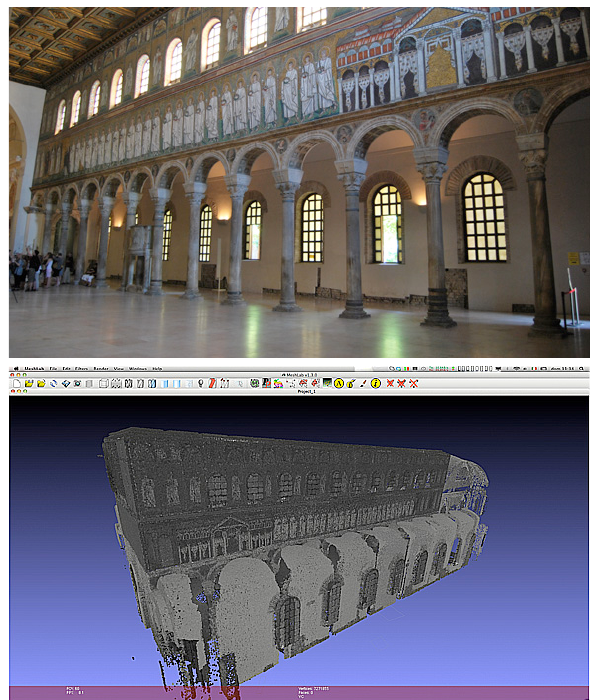
Figure 1. Sant’Apollinare Nuovo: the early Byzantine church is famous worldwide for its nave surrounded by walls covered with mosaics (top image). Some 3D laser scanner and digital photogrammetric surveys were performed in order to obtain a registered point cloud of interiors (bottom